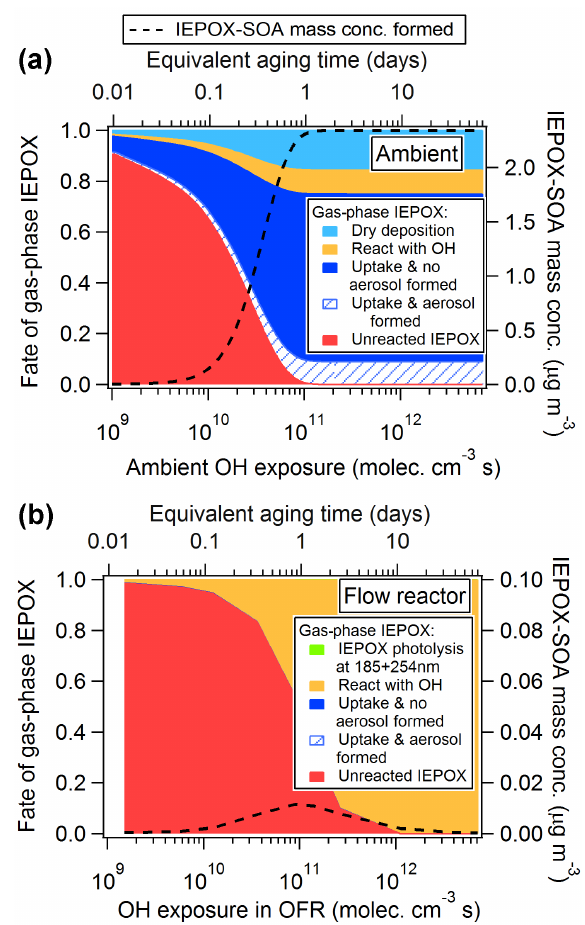
Figure 4. Modeled IEPOX fate (a) in ambient air and (b) oxidation flow reactor (OFR) conditions in the SE US study. The uptake rate of gas-phase IEPOX onto aerosol is calculated by using the model of Gaston et al. (2014), and is mainly influenced by aerosol pH (es- timated as 0.8 and 1.35 for ambient and OFR aerosol, respectively) and aerosol surface areas (300 and 350µm 2 cm − 3 for ambient and OFR aerosol, respectively). The calculated IEPOX-SOA mass con- centrations are shown in the right axis of this figure. The OH expo- sures for both panels range 15min − 2 months of atmospheric equiv- alent age (at OH concentration = 1.5 × 10 6 moleccm − 3 )